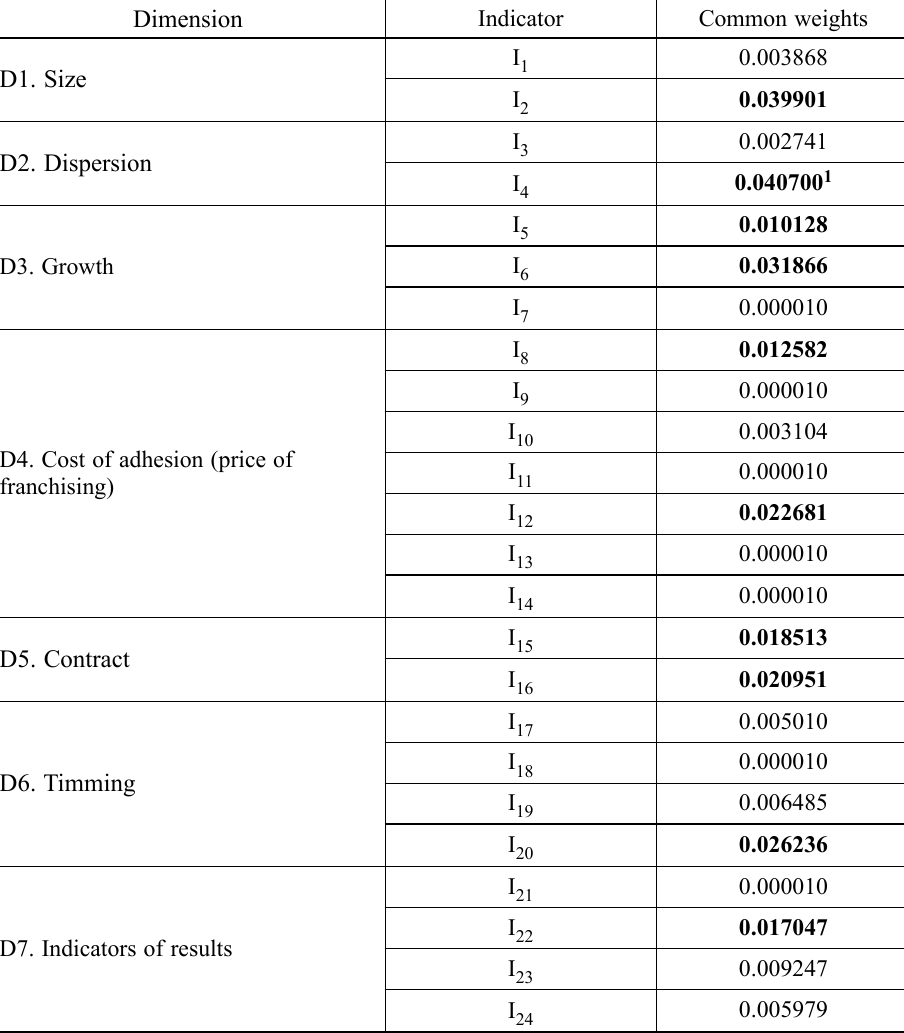
Table 5. Common weighting system associated to global composite indicator Dimension Indicator Common